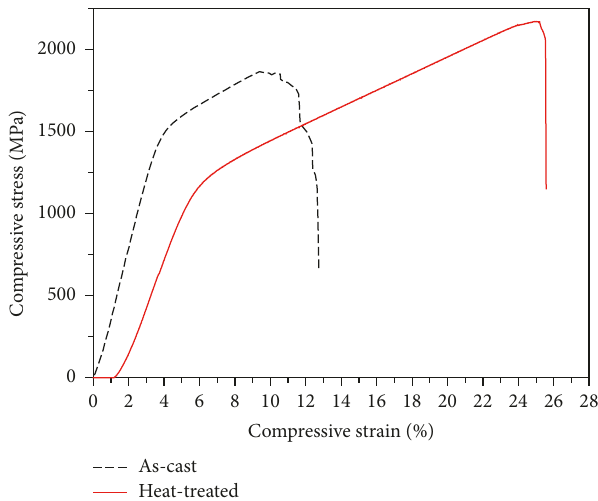
Figure 6: Engineering stress-strain curve of bulk AlCoCuFeMnNi HEA under